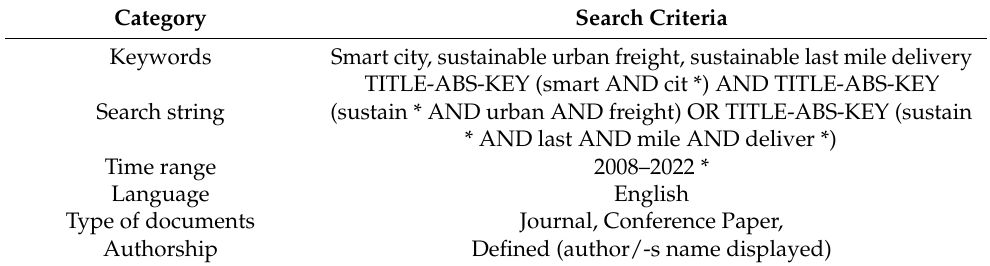
Table 2. Search criteria in Scopus database